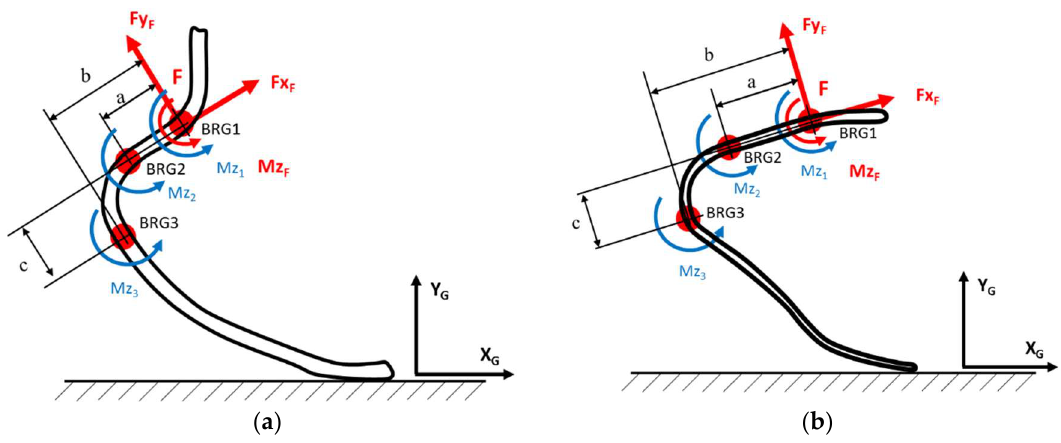
Figure 4. Sensing concept adopted for the instrumented running prosthetic foot. Three bending bridges sensing the bending moment Mz 1 , Mz 2 , and Mz 3 at known locations allow reconstructing the three load components Fx F , Fy F , and Mz F at the Foot reference system origin F. ( a ) Example of a J-shaped instrumented running prosthetic feet (RPF). ( b ) Example of a C-shaped instrumented RPF.